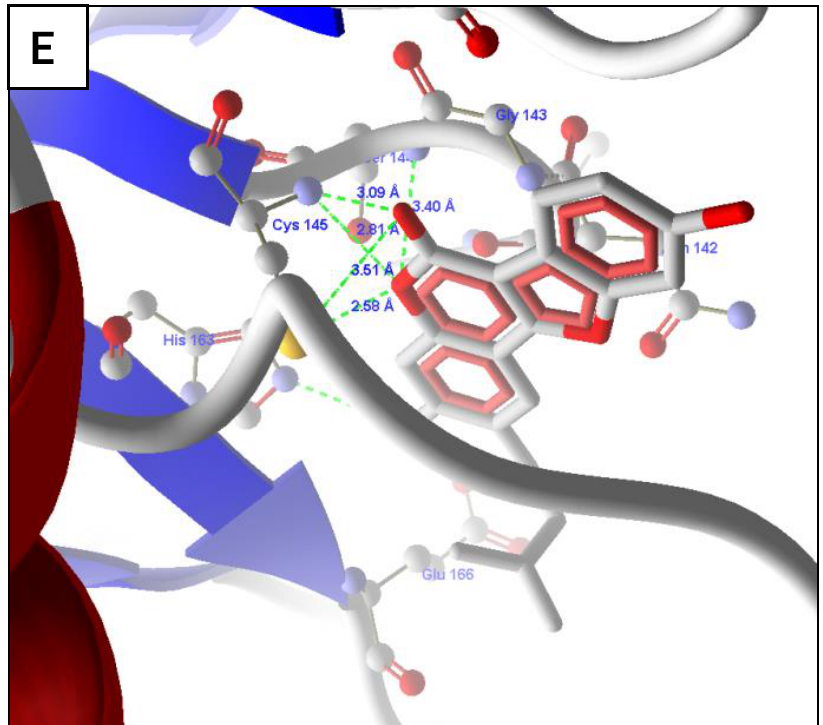
Figure 3. Molecular interactions with the top hits from the virtual screenings of ( A ) daidzin, ( B ) naringerin, ( C ) phloretin, ( D ) rosmeric acid, and ( E ) psoralidin. Table 2. Physicochemical properties of selected compounds.